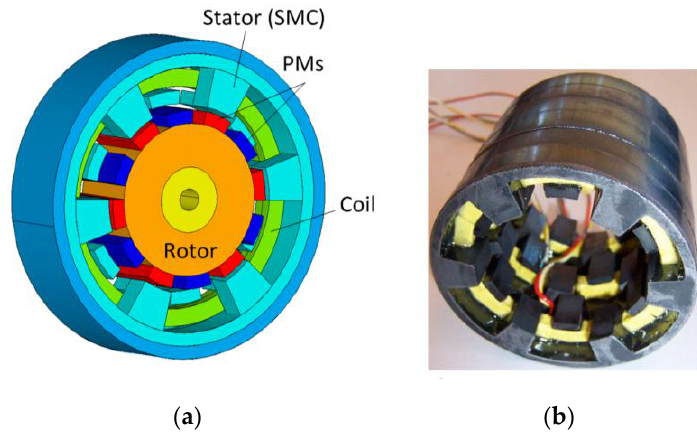
Figure 8. Structure of the CPM ( a ) and its SMC stator prototype ( b ). Energies 2017 , 10 , 1962